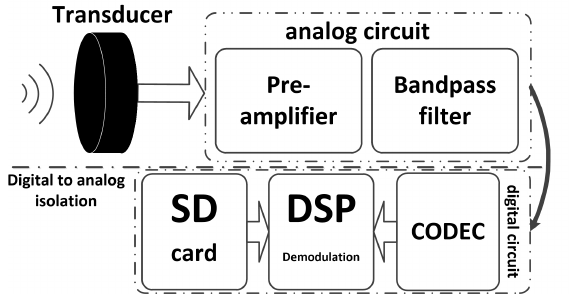
Figure 5. Functional diagram of the